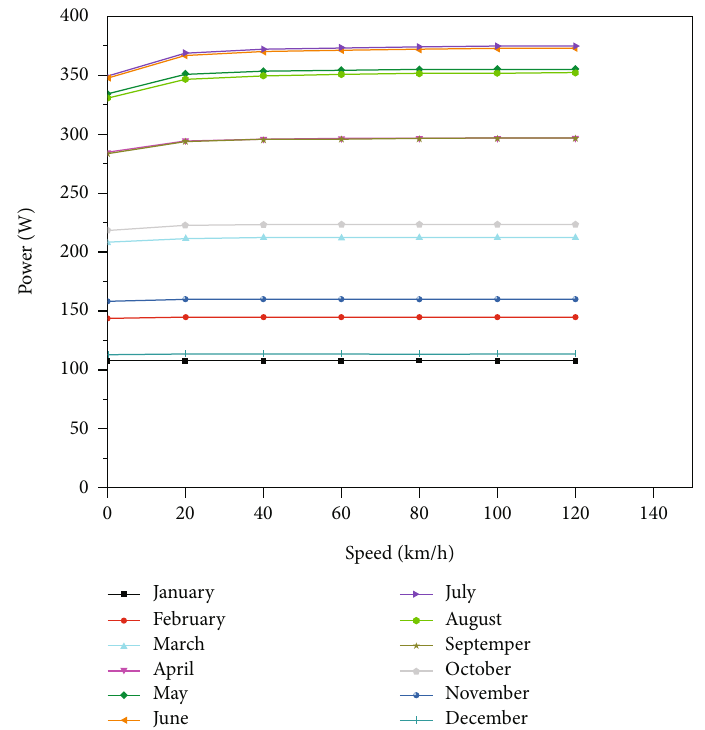
Figure 8: Power-speed images for di ff erent